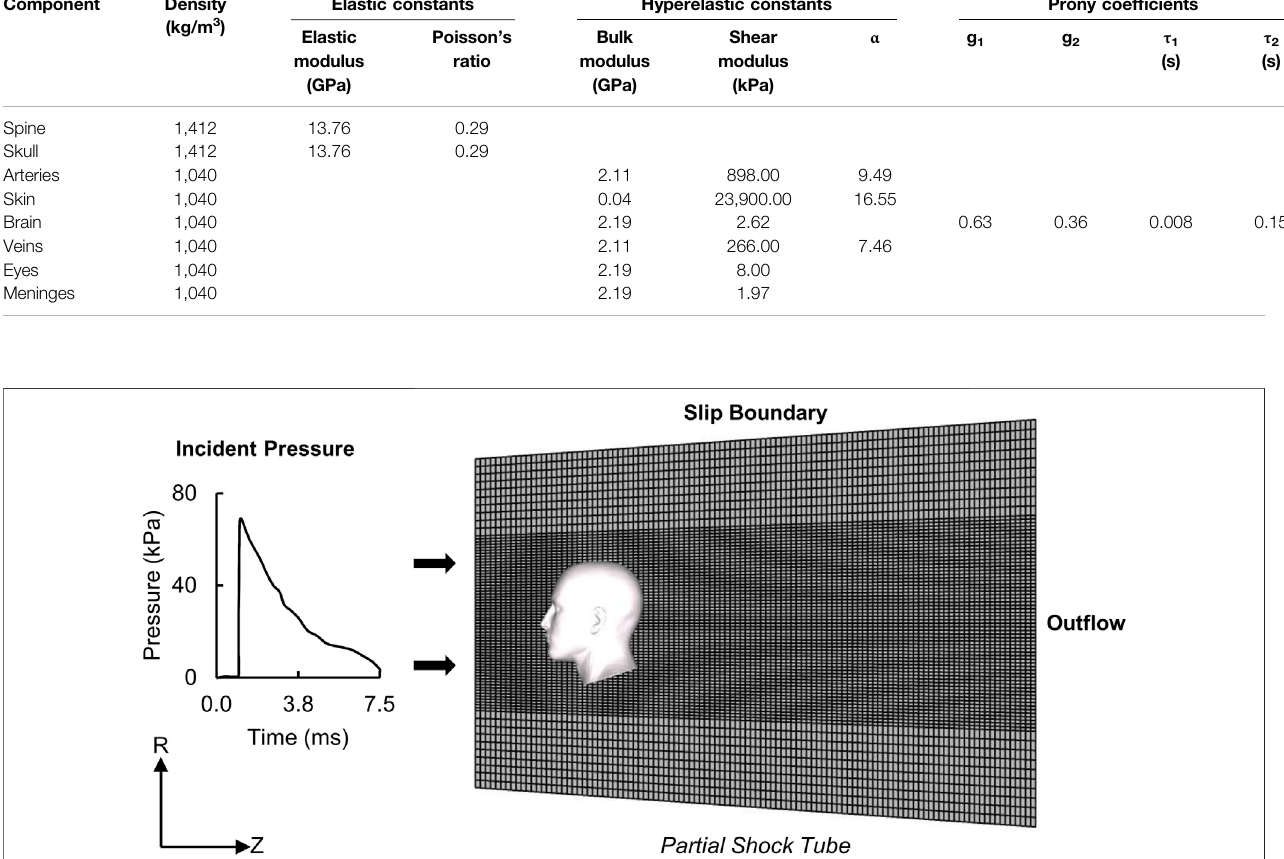
Frontiers in Bioengineering and Biotechnology |